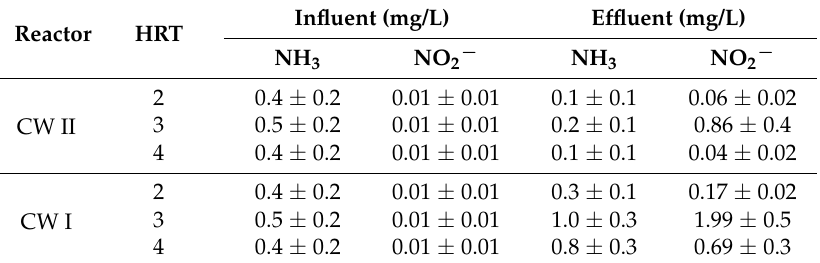
Table 1. The NH 3 and NO 2 − accumulation under different hydraulic retention time